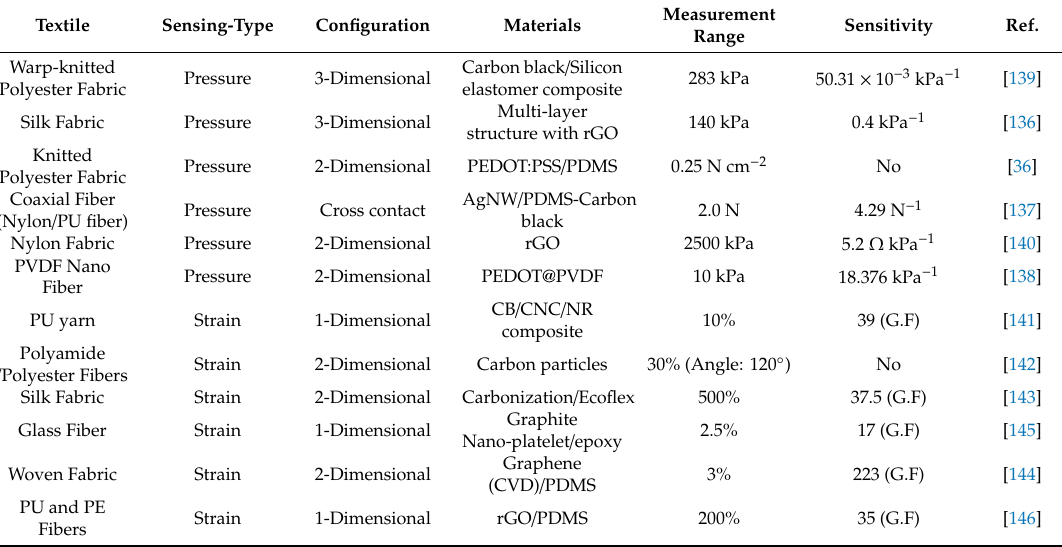
Table 1. Summary of textile-based pressure / strain sensors and their sensing